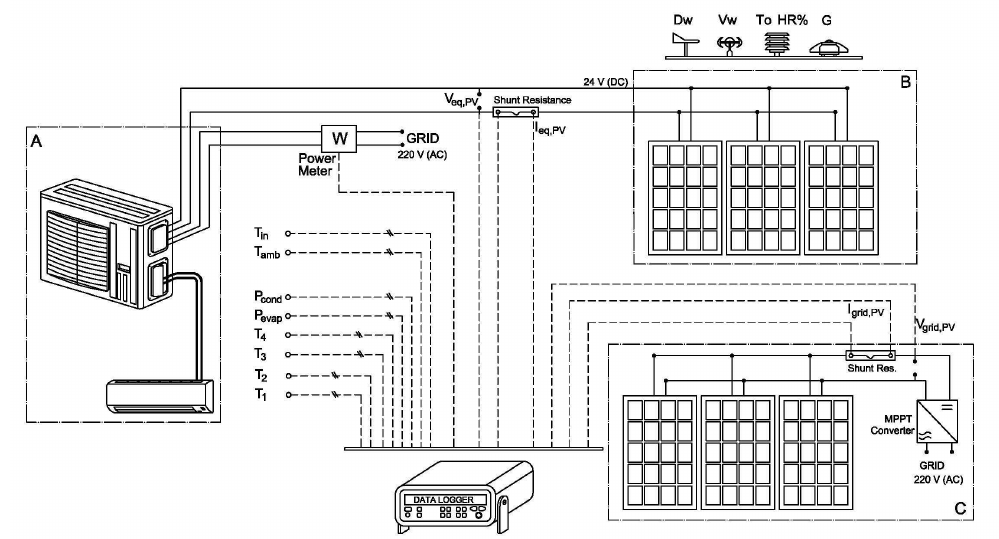
Figure 1. Experimental facility. A air-conditioning heat pump. B PV panels connected to the heat pump. C PV panels connected to the grid. Reprinted from Aguilar et al. [8] with permission, 2017, Elsevier.